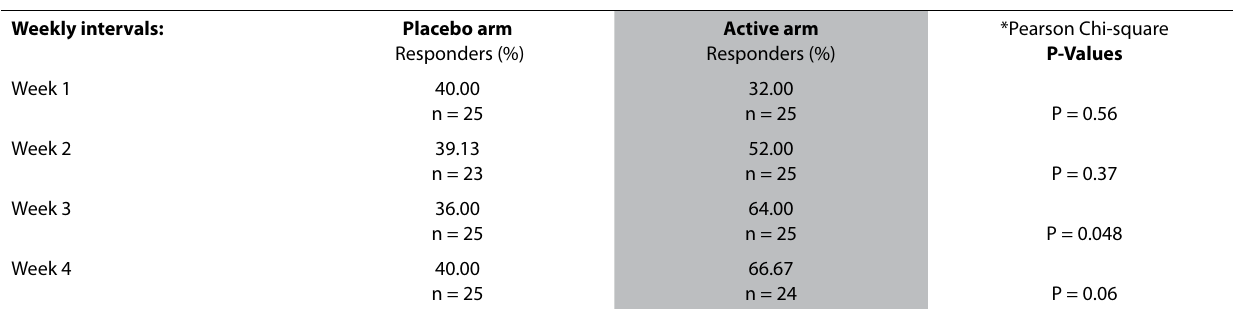
Table 2: Overall responders Overall responders reported for Placebo and Active groups Weekly intervals: